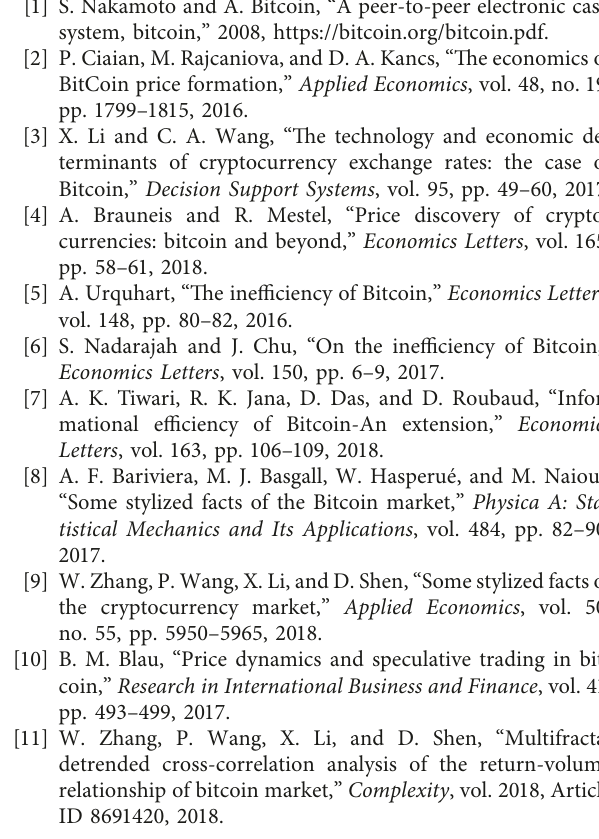
Figure 7: Spectrum singularity of f( α ) versus α for BTC and USEPU cross-correlation, the correlation of BTC, and the corre- lation of USEPU. Table 2: Max, min, and delta values of the H¨older